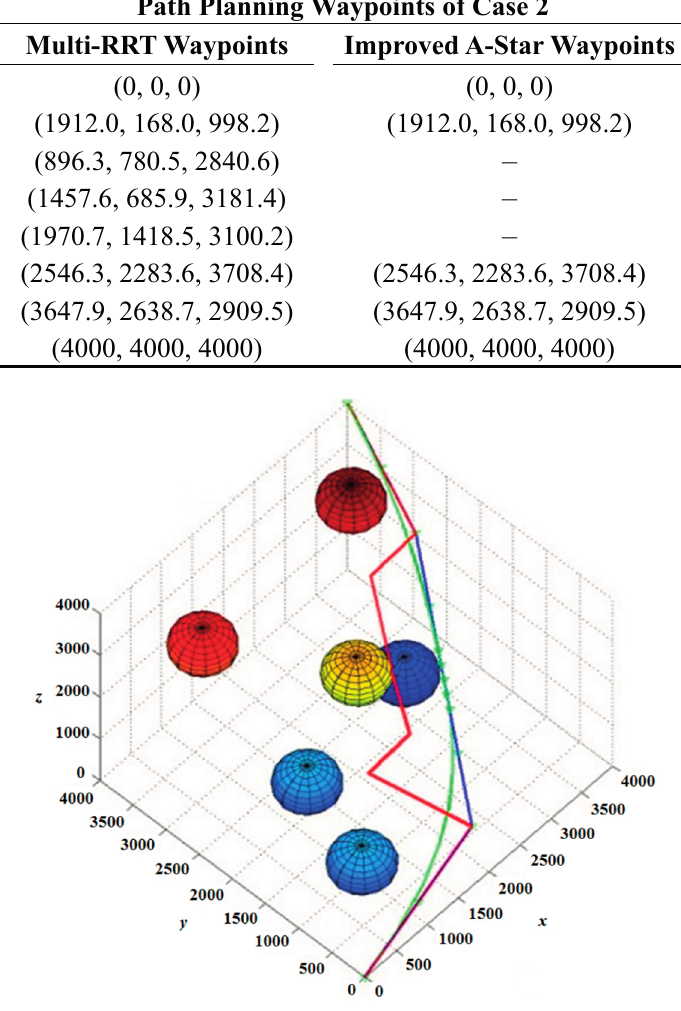
Figure 13. Results of path planning via the multi-RRT and improved A-star algorithms and the finalized path after introducing Bezier curves in Case 2 (unit: